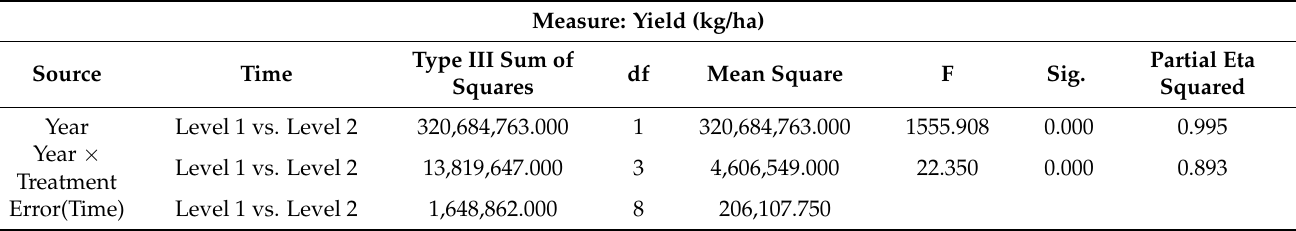
Table 6. Tests of within-subjects contrasts, two-way ANOVA (treatment, year) with analysis of interactions. Measure: Yield